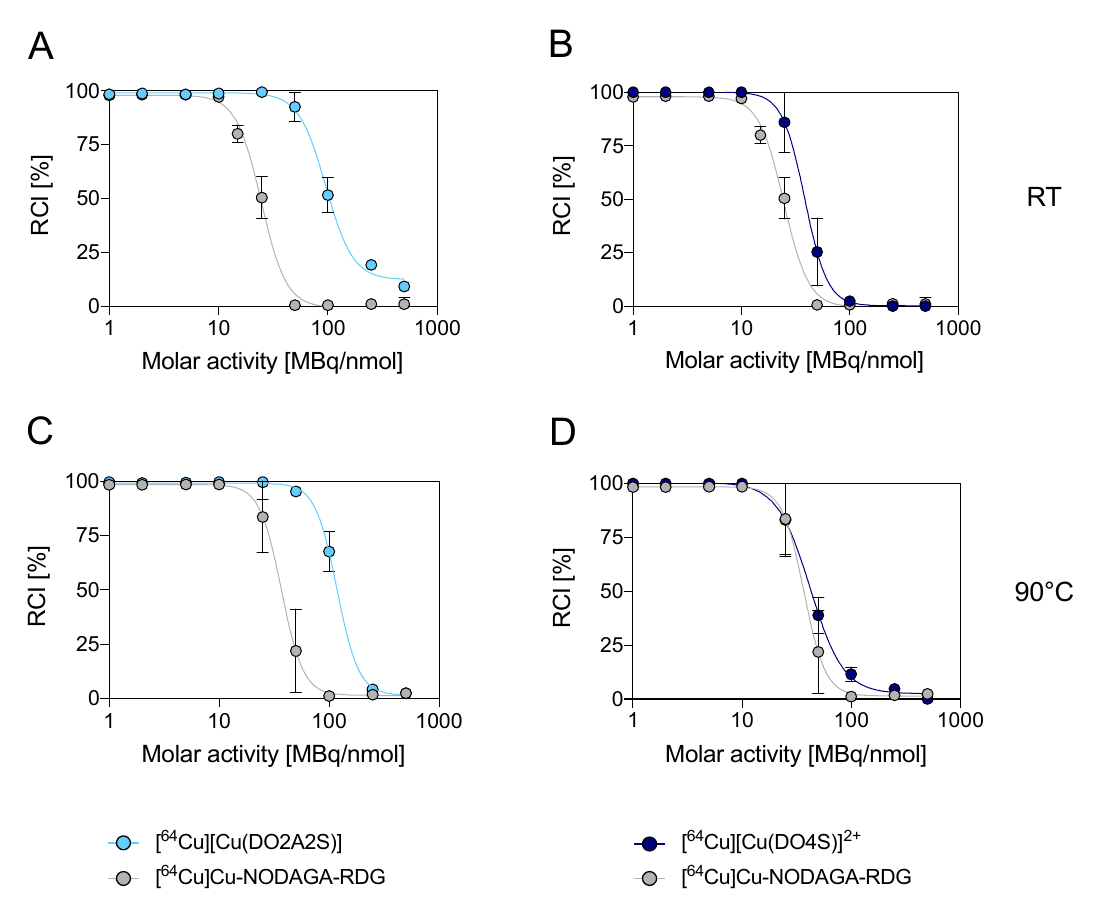
Figure 3. [ 64 Cu]Cu 2+ incorporation yields (10 min, pH 7) at different molar activities for DO2A2S and DO4S. ( A , B ): RT; ( C , D ): 90 °C. Incorporations are compared with those obtained with NODAGA-RDG under the same conditions.